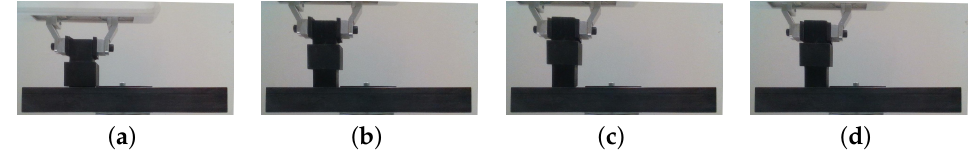
Figure 4. Different outcomes of the PiH task. ( a ) Successful insertion with correct parameters. ( b ) Insertion failure due to grasping error. ( c ) Insertion failure due to a positional error in the x -direction. ( d ) Insertion failure due to a positional error in the y -direction.